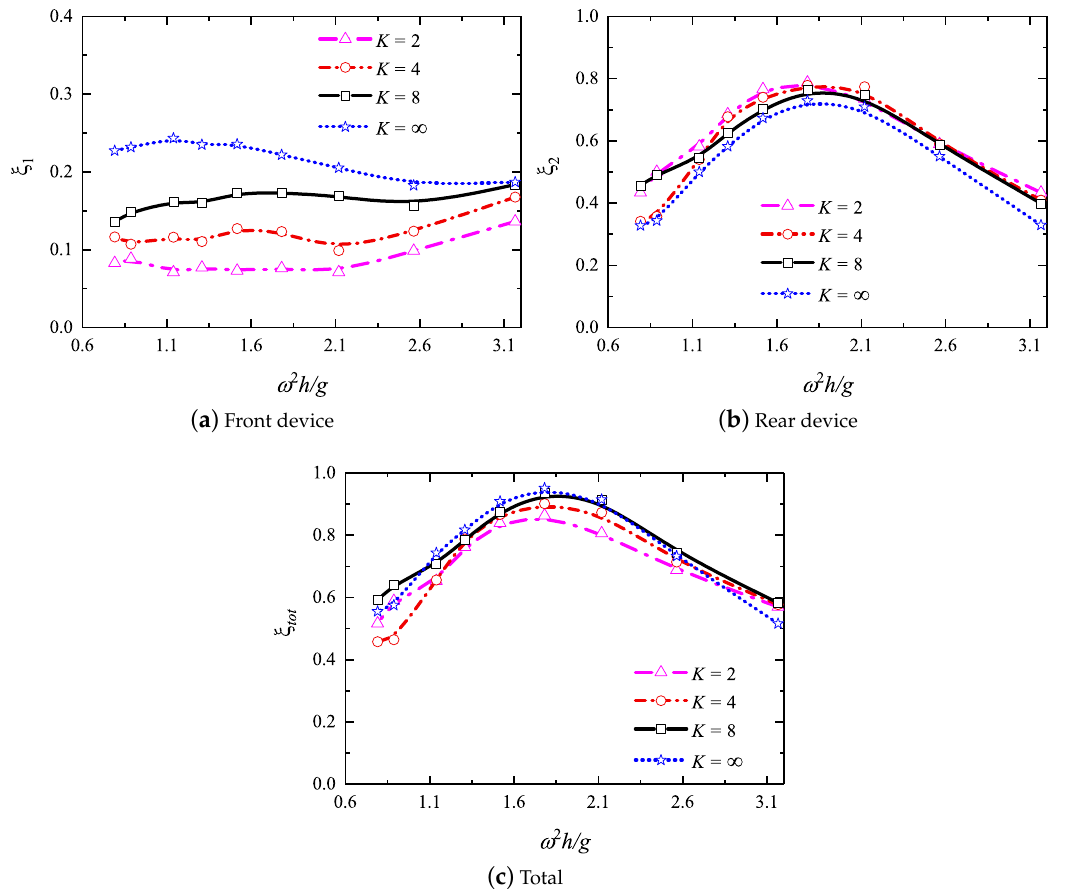
Figure 16. Effects of spring coefficients K on the hydrodynamic efficiencies. In all cases, b 1 = 0.1 m, b 2 = 0.2 m, d 1 = d 2 = d 3 = 0.05